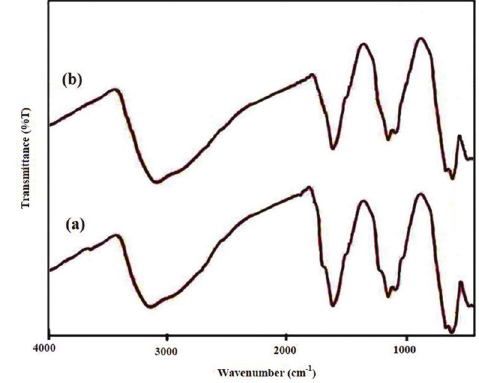
O @SiO -L-proline nanoparticles as 3 4 2